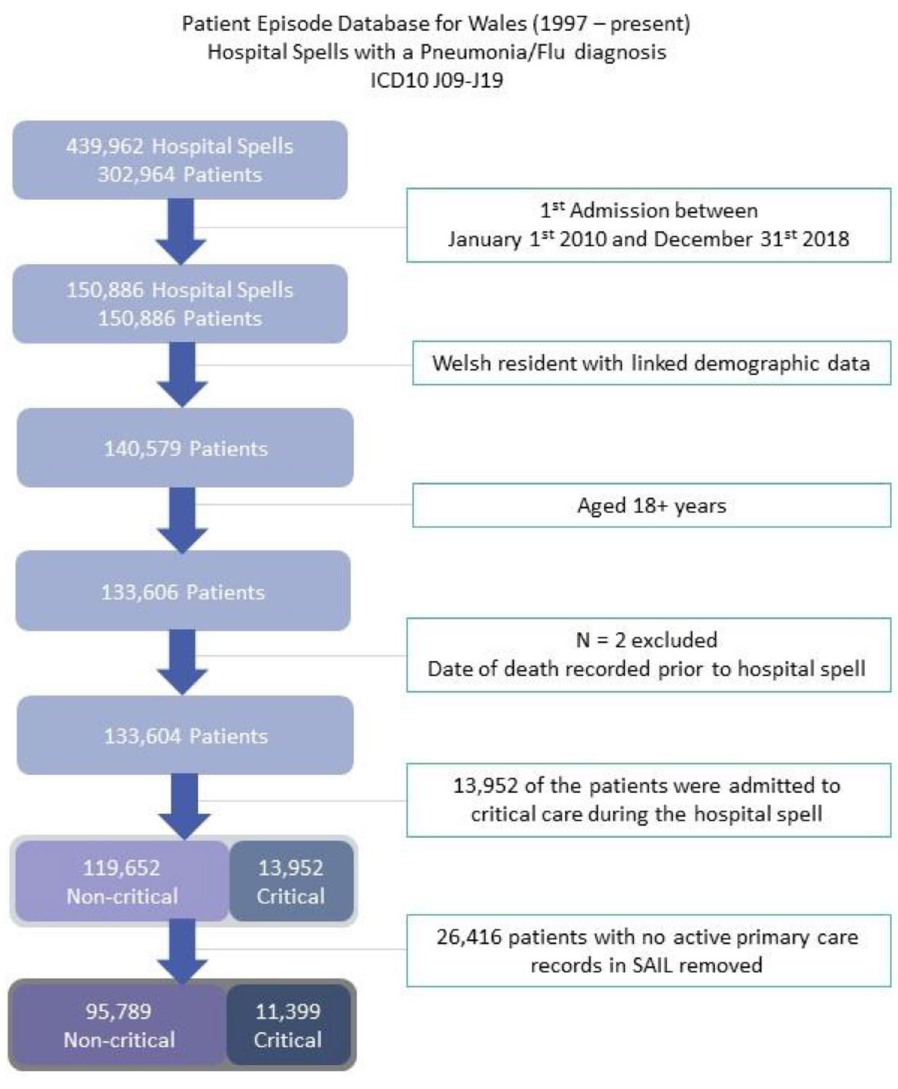
Figure 1. CONSORT diagram for the number of patients in the study. eFI electronic Frailty Index; HFRS Hospital Frailty Risk Score; ICU Intensive Care Unit; SAIL (Secure Anonymised Information Linkage)